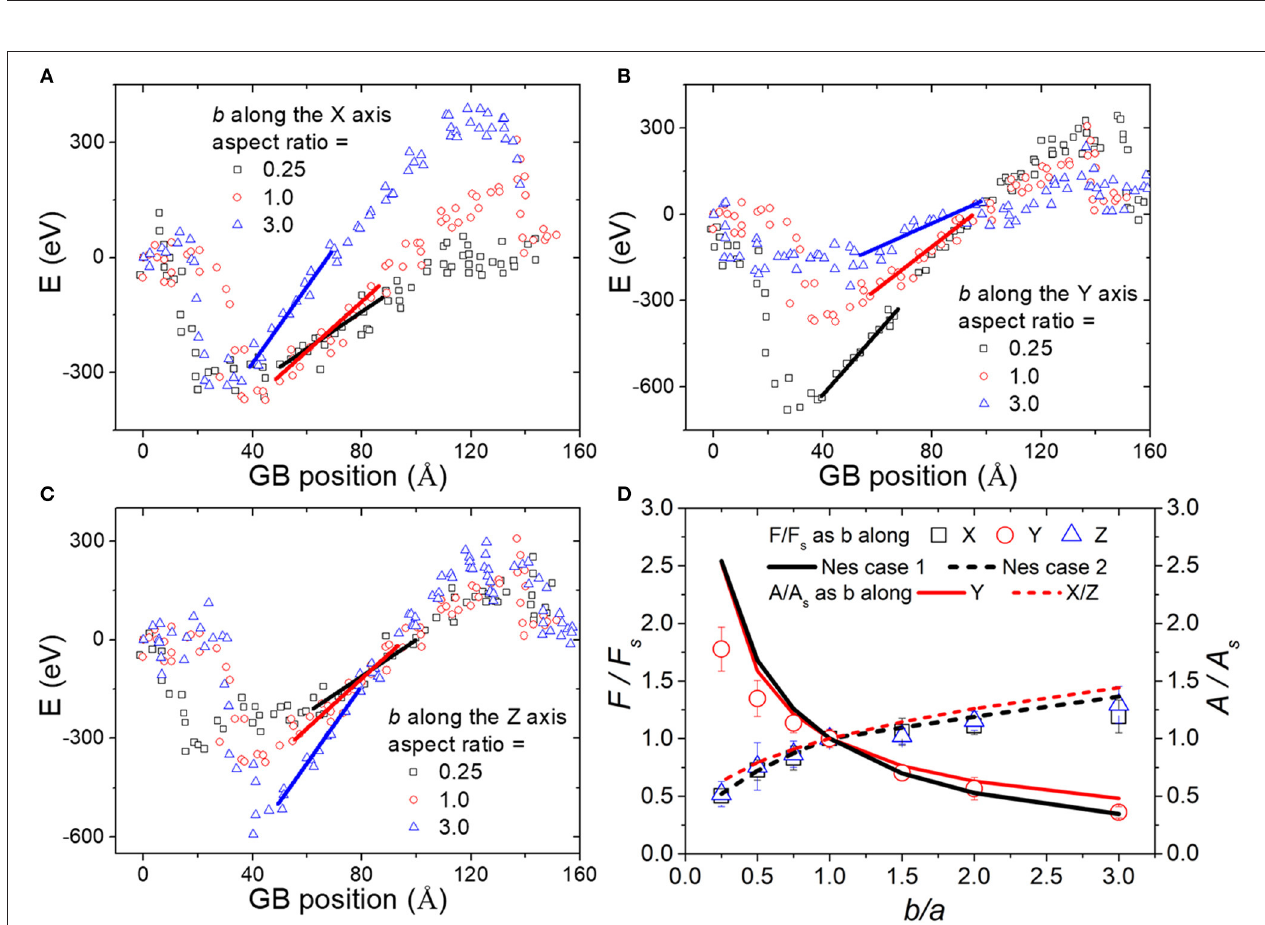
FIGURE 4 | Configurations right before the detachment of the boundaries from the particles (See online article for color version of this figure).